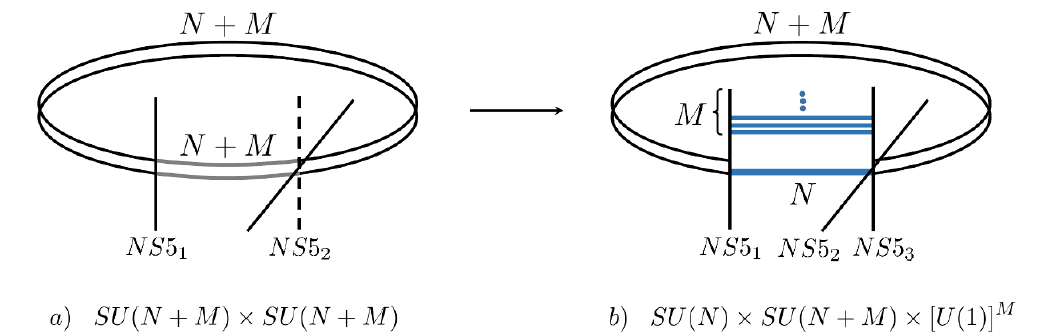
Figure 20 . The type IIA dual description of the UV completion as well as the Higgsing e(cid:11)ect. Figure (a) represents a CFT whereas (cid:12)gure (b) shows how cascading theory can be realized. The absence of a Coulomb branch in (cid:12)gure (a) indicates that one cannot move the straddling D4 branes around to Higgs the underlying gauge theory. Also the NS5-branes are not bent, so there is no RG (cid:13)ow. In (cid:12)gure (b) and third NS5-brane is added without breaking any supersymmetry. This is almost like the remnant of the N = 2 Coulomb branch. Higgsing can now be done resulting in the bendings of the NS5-branes and triggering the RG (cid:13)ows. The far IR will be a con(cid:12)ning SU( M